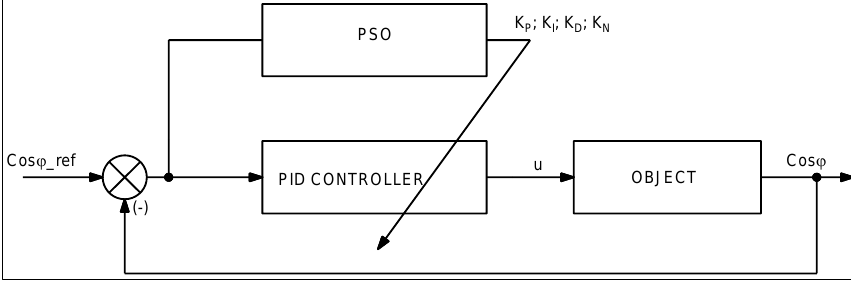
Figure 12. PSO-based PID